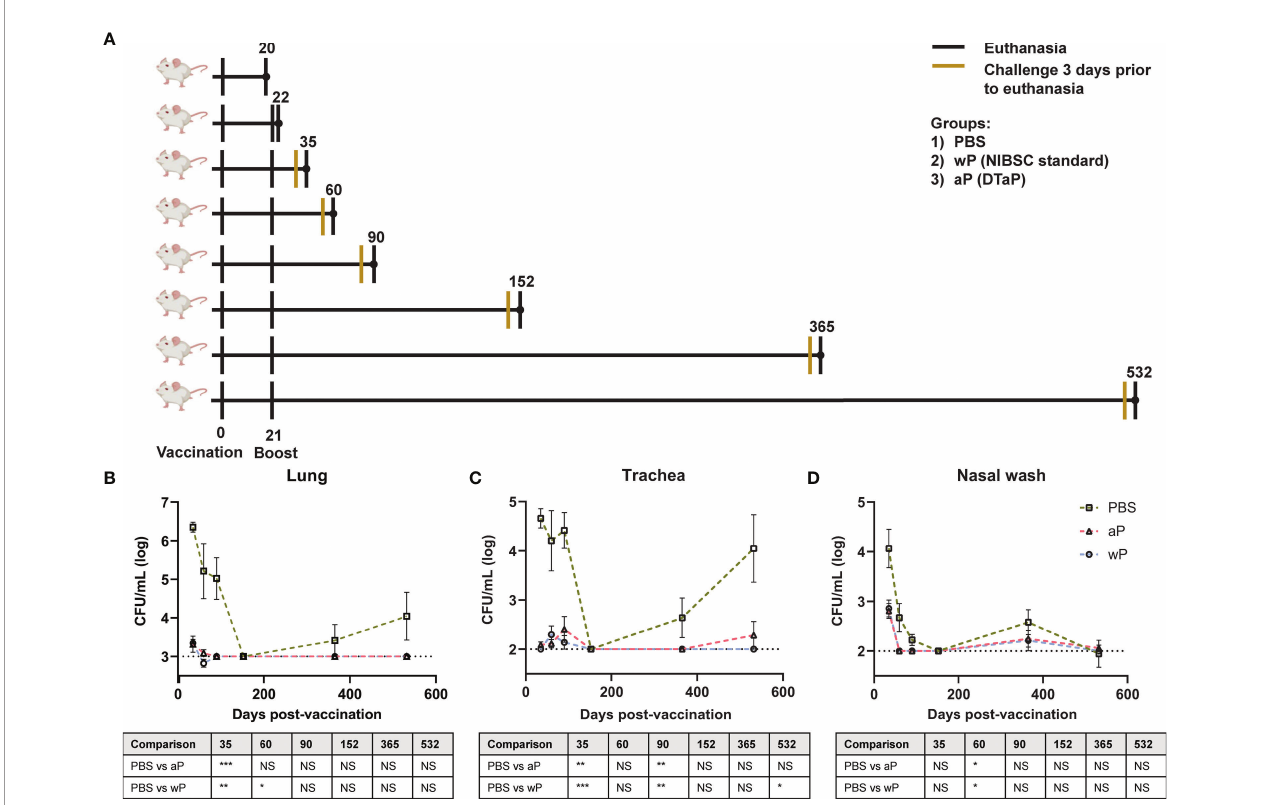
FIGURE 1 | Susceptibility to B . pertussis in CD1 mice changes depending on age. (A) Experimental design and vaccination timeline. Mice were vaccinated at day 0 and boosted at day 21. Vertical black lines indicate the day that non-challenged mice were processed post-vaccination. Mustard colored lines represent groups of mice that were challenged three days prior to processing. (B – D) Bacterial burden in mice challenged with B. pertussis . Mice were vaccinated on day 0 with PBS, aP, or wP at 1/10 th the human dose and boosted with the same vaccine at day 21. Mice were challenged with 2x10 7 CFU/dose by intranasal instillation 3 days prior to euthanasia. Bacterial burden of PBS vaccinated mice in the lung (B) , trachea (C) , and nasal wash (D) . PBS was used as a vehicle control. Days 35, 60, and 90 are from two independent experiments (n=8). Days 152 (n=4), 365 (n=8), and 532 (n=4) were from one independent experiment each. Data were log10-transformed. The p-values were calculated for each time point using ANOVA followed by a Tukey ’ s multiple-comparison test, *p < 0.05, **p < 0.01, and ***p < 0.001. NS indicates no signi fi cance. Error bars are mean ± SEM